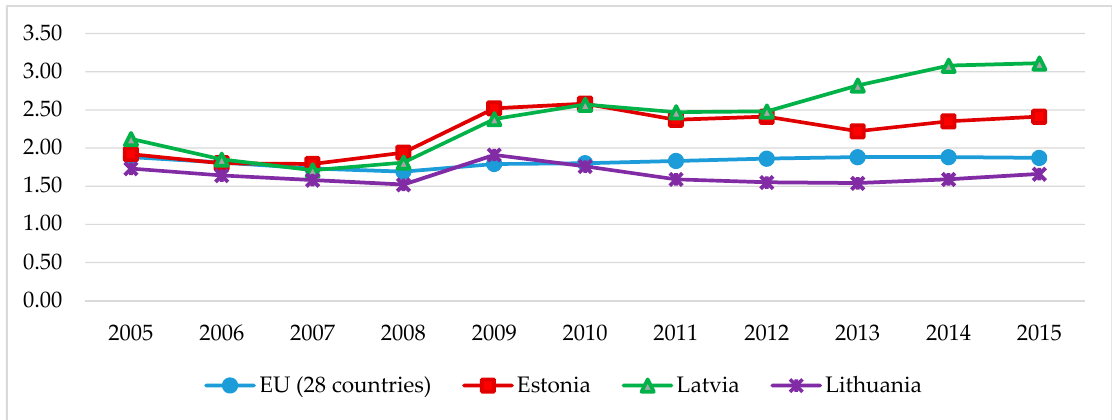
Figure 2. Revenues from environmental taxes in the Baltic States, as the percentage of gross domestic product (GDP). EU: European Union.